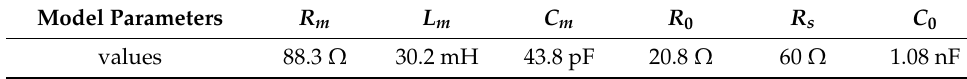
Table 1. Parameters of the equivalent circuit model for ME resonator at H dc of 30 Oe.